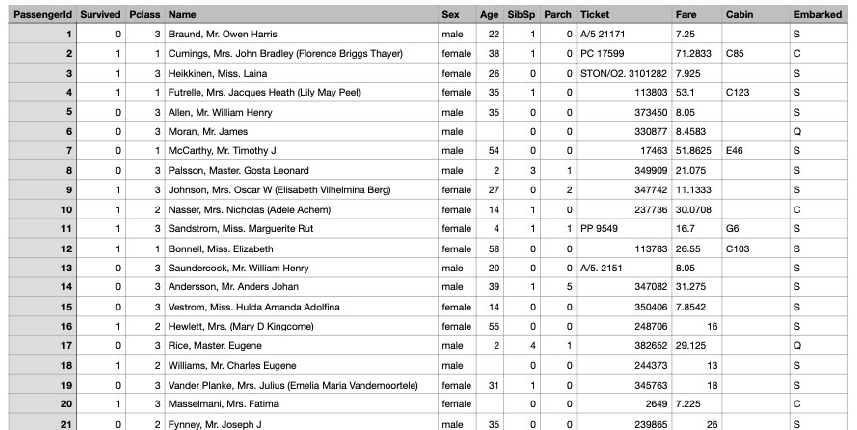
Figure 7. The Titanic data set is represented in an Excel table that contains data for 891 of the real Titanic passengers, some entries are not